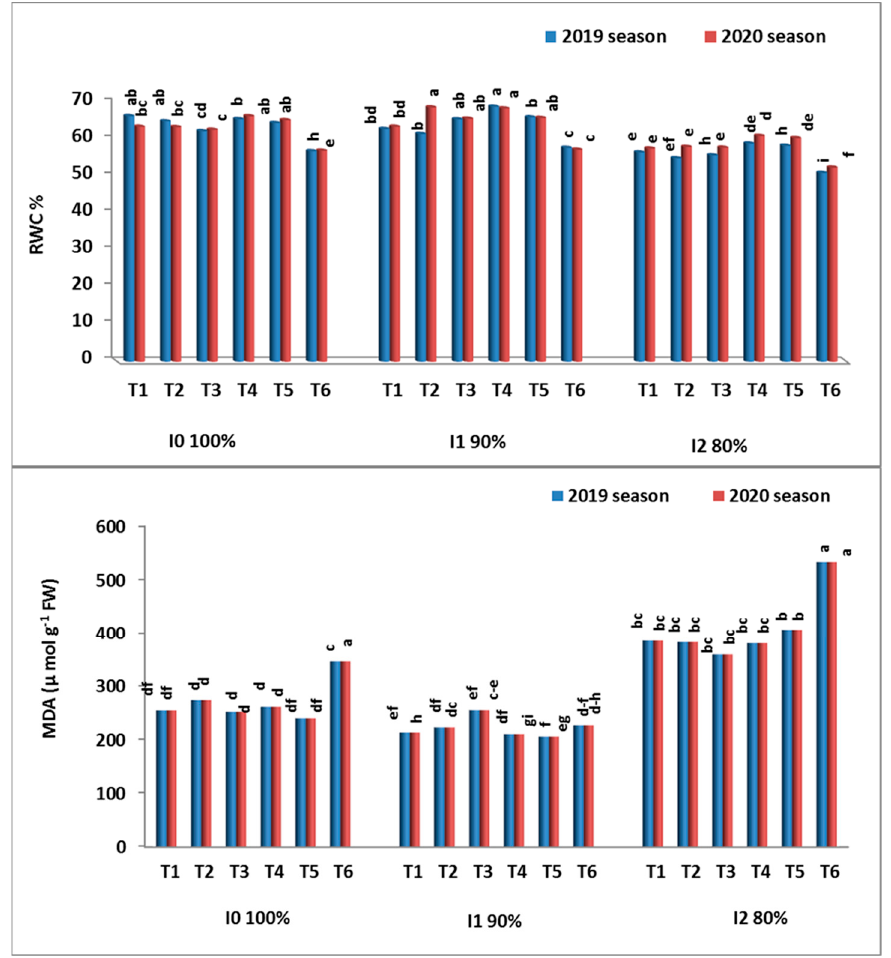
Figure 5. Effect of interactions between irrigation levels and weed control treatments on RWC% and MDA during the 2019 and 2020 seasons; I 0 : 100% irrigation level T 1 : pendimethalin CS 45.5% T 4 : imazethapyr WG 60%; I 1 : 90% irrigation level T 2 : oxyfluorfen EC 24% T 5 : hand-hoeing